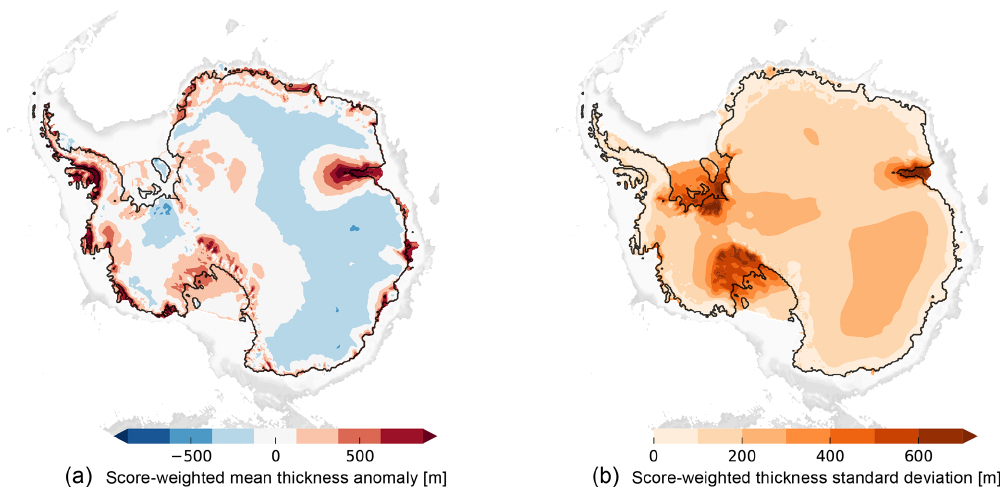
Figure 6. Score-weighted mean ice thickness anomaly to Bedmap2 (a) and score-weighted standard deviation of ice thickness (b) . Ice thickness in coastal regions in West Antarctica but also in the Amery basin are generally overestimated. Amery and Filchner–Ronne ice shelves and Siple Coast region reveal the highest standard deviation in reconstructed present-day ice thickness among the ensemble members.